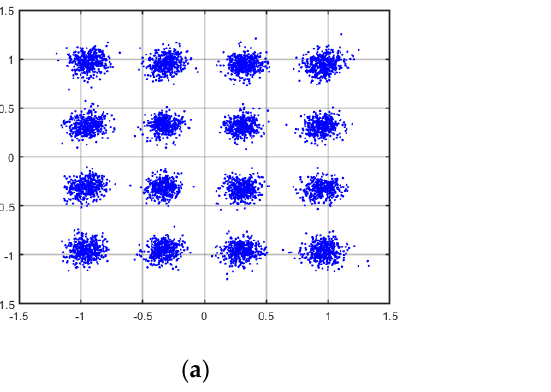
Figure 5. ( a ) Measured constellation of the IF loopback system, and ( b ) BER in relation to the system SNR.